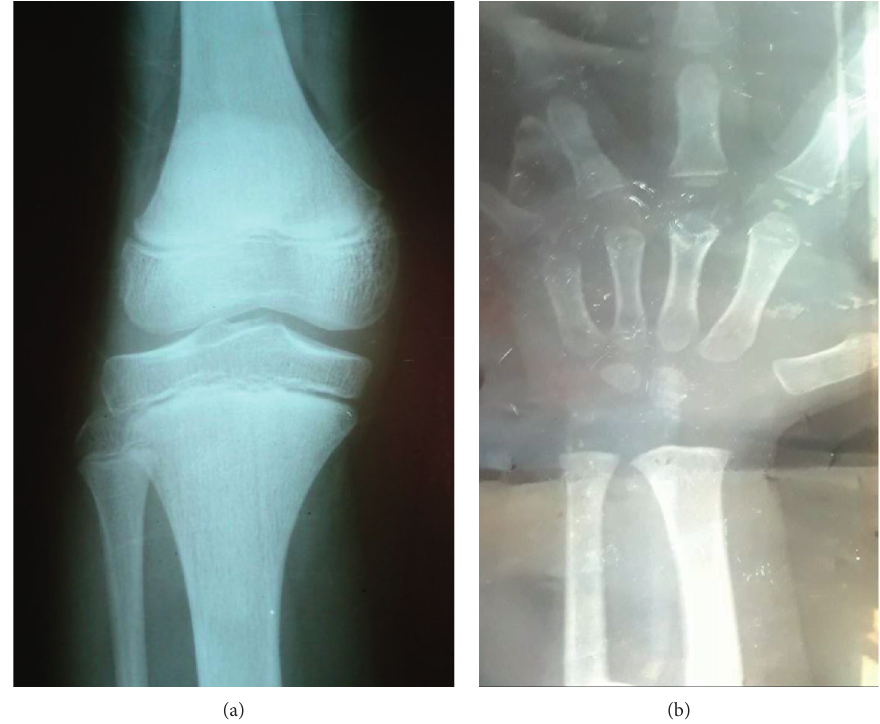
Figure 1: (a) The left hand and wrist bones of the first patient which is consistent with a bone age of 3 years. (b) Posterior-anterior image of the left knee of the second patient reveals the open epiphysis of the growth